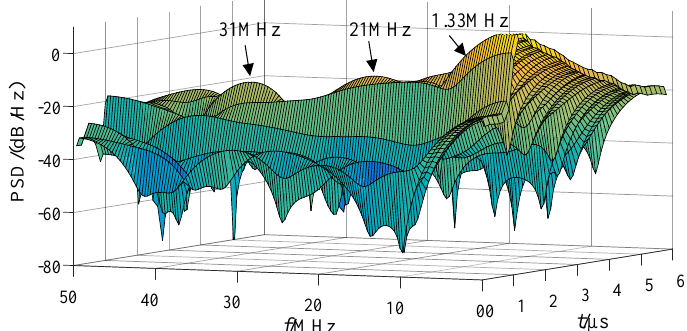
Figure 11. Synthetic magnetic field strength.